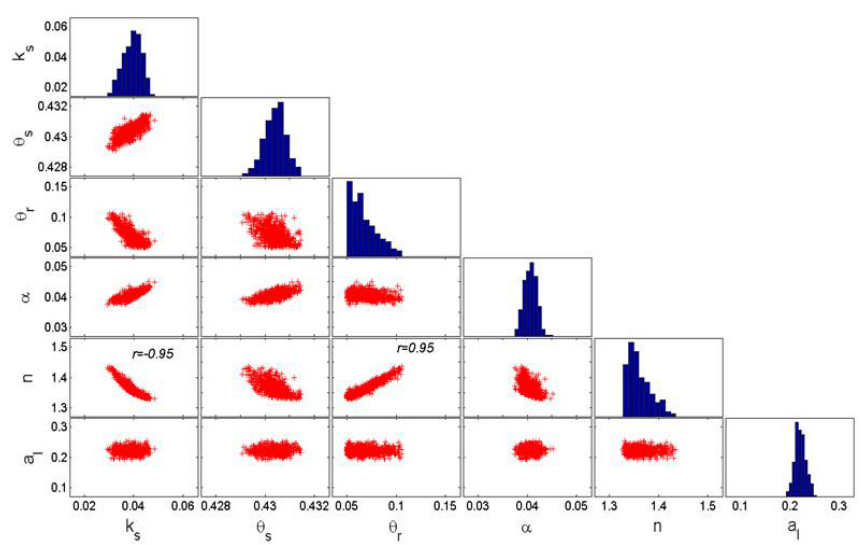
Figure 7. MCMC solutions for transport scenario 6 (see Fig. 2